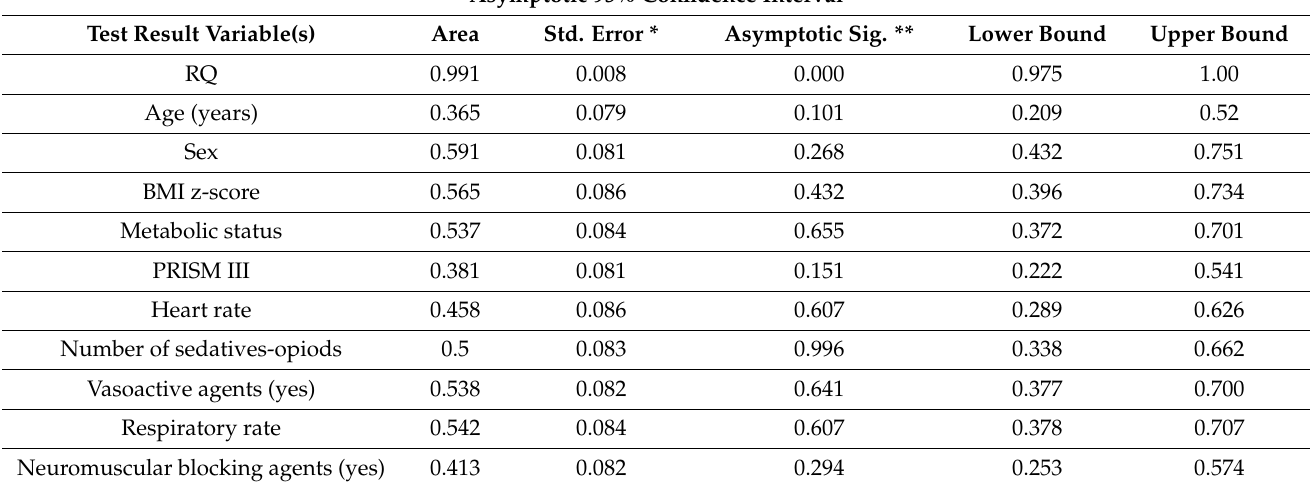
Table 4. Area Under the Curve for variables predicting REE VCO2 RQ 0.89 inaccuracy by underestimat- ing REE IC for more than − 10%.